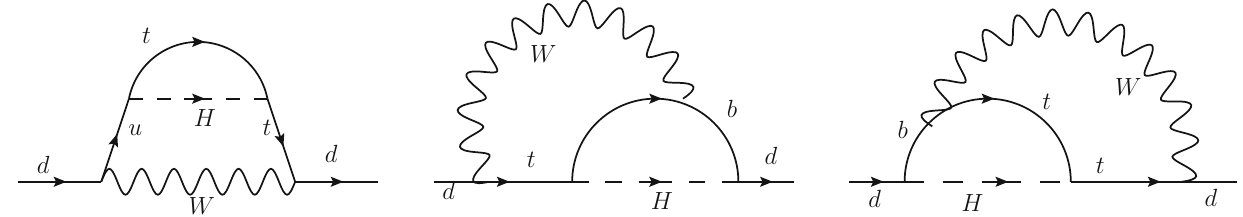
will get contributions which are not suppressed by light quark masses. The diagram to the right is the complex conjugate of the diagram in the middle